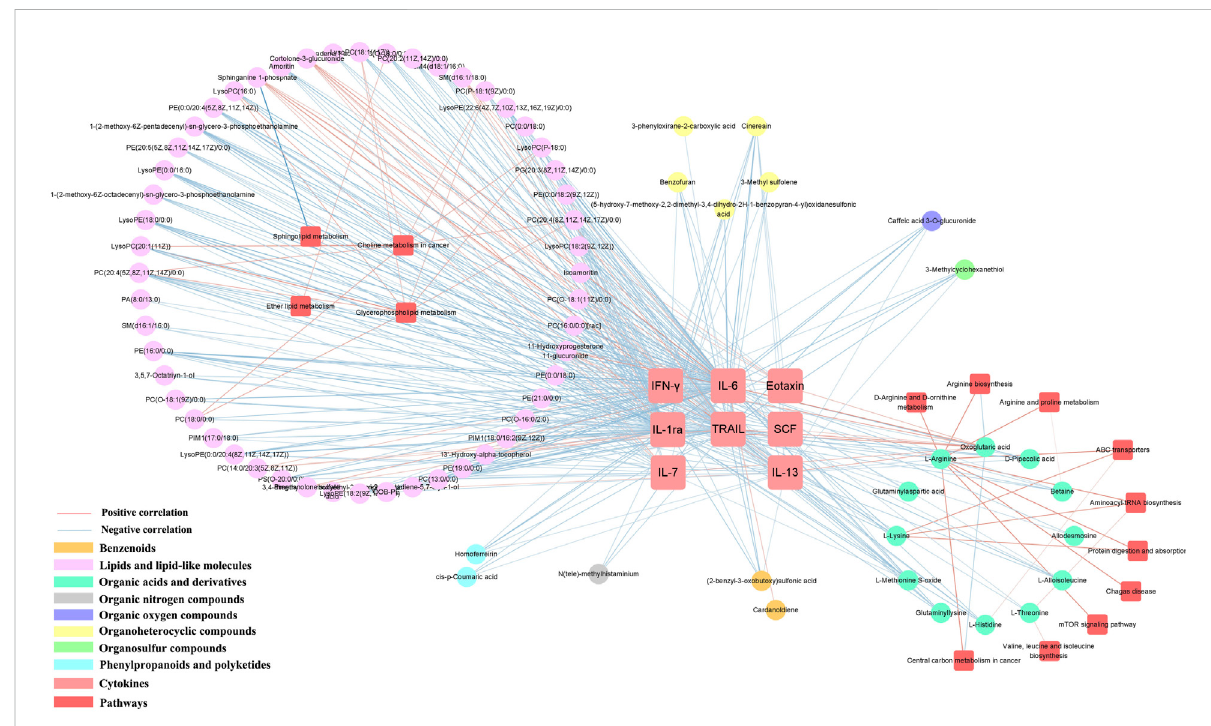
FIGURE 6 Metabolite-cytokine correlation in serum samples. Only metabolite correlations with |PCC| ≥ 0.9 and p < 0.001 were